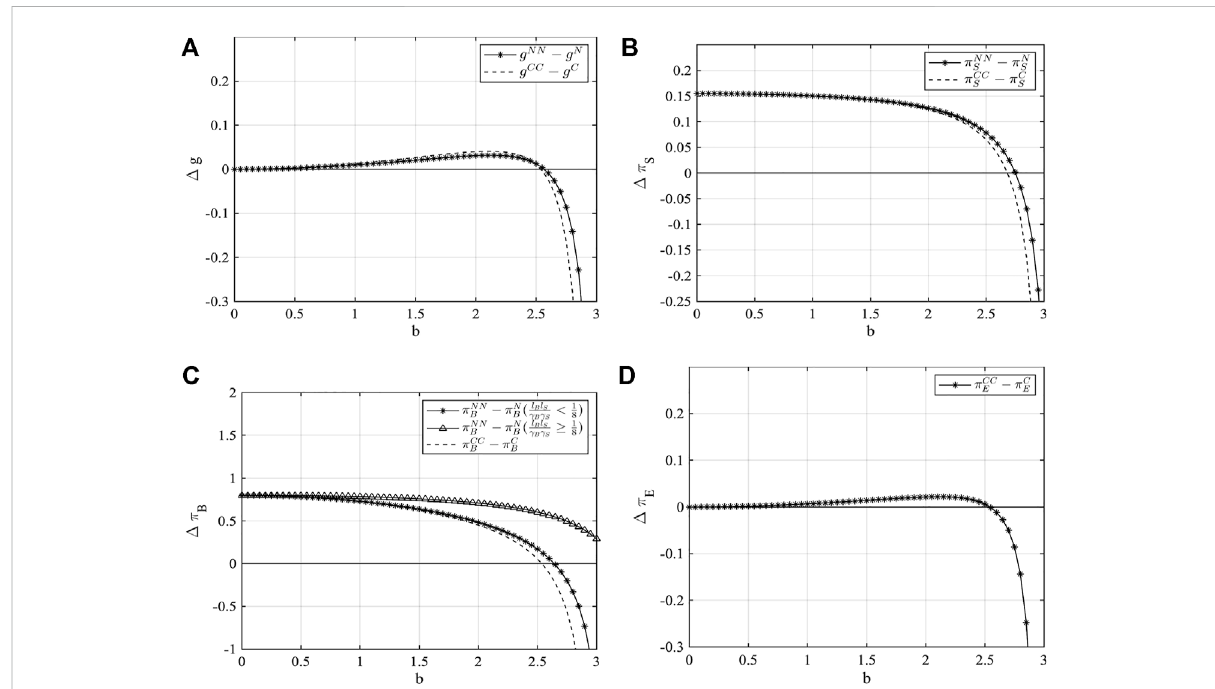
FIGURE 3 Comparison of total environmental efforts and pro fi ts of members. Notes. With the constraint satis fi ed, we set w = 0.1; c = 0.8; l B = 0.2; γ B = 5; l S = 0.15; γ S = 1; h = 0.6. (A) Comparison of total environmental efforts. (B) Comparison of suppliers ’ pro fi ts. (C) Comparison of core enterprises ’ pro fi ts. (D) Comparison of ENGOs ’ pro fi